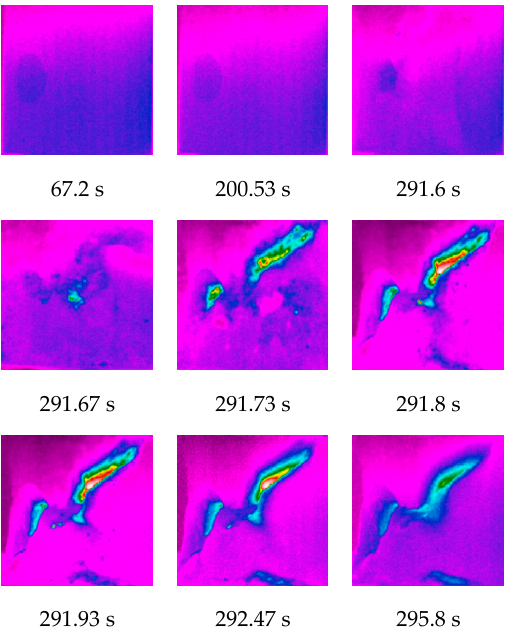
Figure 8. Cloud diagram of temperature field change during DL5-3 specimen failure.